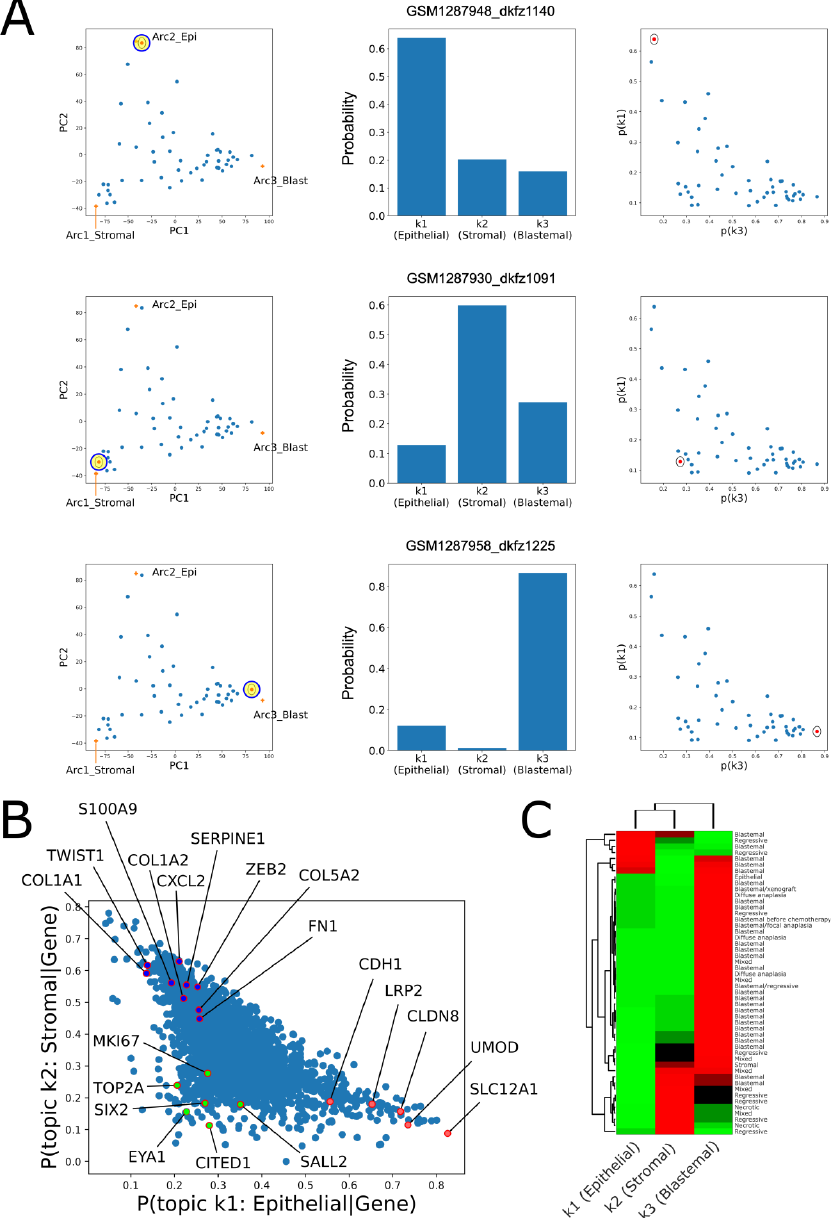
Figure 3. Topic modeling shows that each tumor can be represented as a unique mixture of three hidden topics with blastemal, stromal, and epithelial characteristics. ( A ) Shown are the fractions of topics (center and right panels) for selected tumors that are located near each of the three arche- types in latent space (left panels). The topic model predicts that each one of these tumors was gen- erated primarily from a single topic. In particular, tumors near the epithelial topic contain a high fraction of topic no. 1 (top panels), tumors near the stromal topic contain a high fraction of topic no. 2 (middle panels), and tumors near the blastemal topic contain a high fraction of topic no. 3 (bottom panels). It can also be seen that the geometry of the topic simplex (right panels) resembles that of the PCA latent space (left panels). ( B ) The posterior probabilities of the three topics given the ex- pression of specific genes show that the three topics have stromal, blastemal, and epithelial char- acteristics. The posterior probability of a topic given the expression of a specific gene represents the